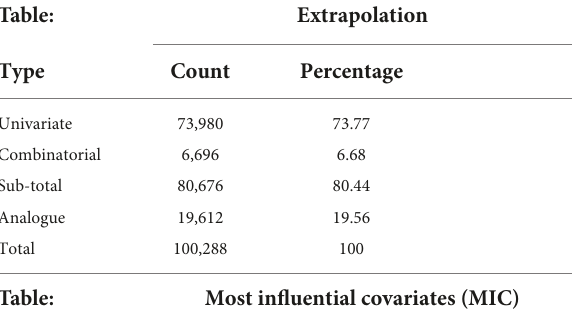
Table: Most influential covariates